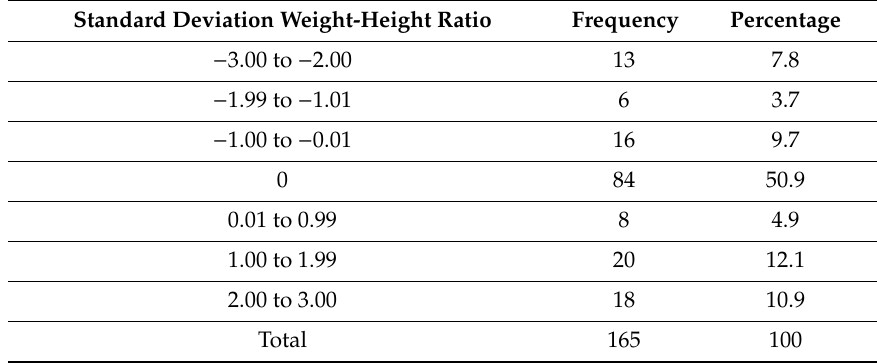
Table 3. Percentage Distribution of Children Under 5 Years of Age, in Relation to the Standard Deviation in the Weight–Height Ratio.